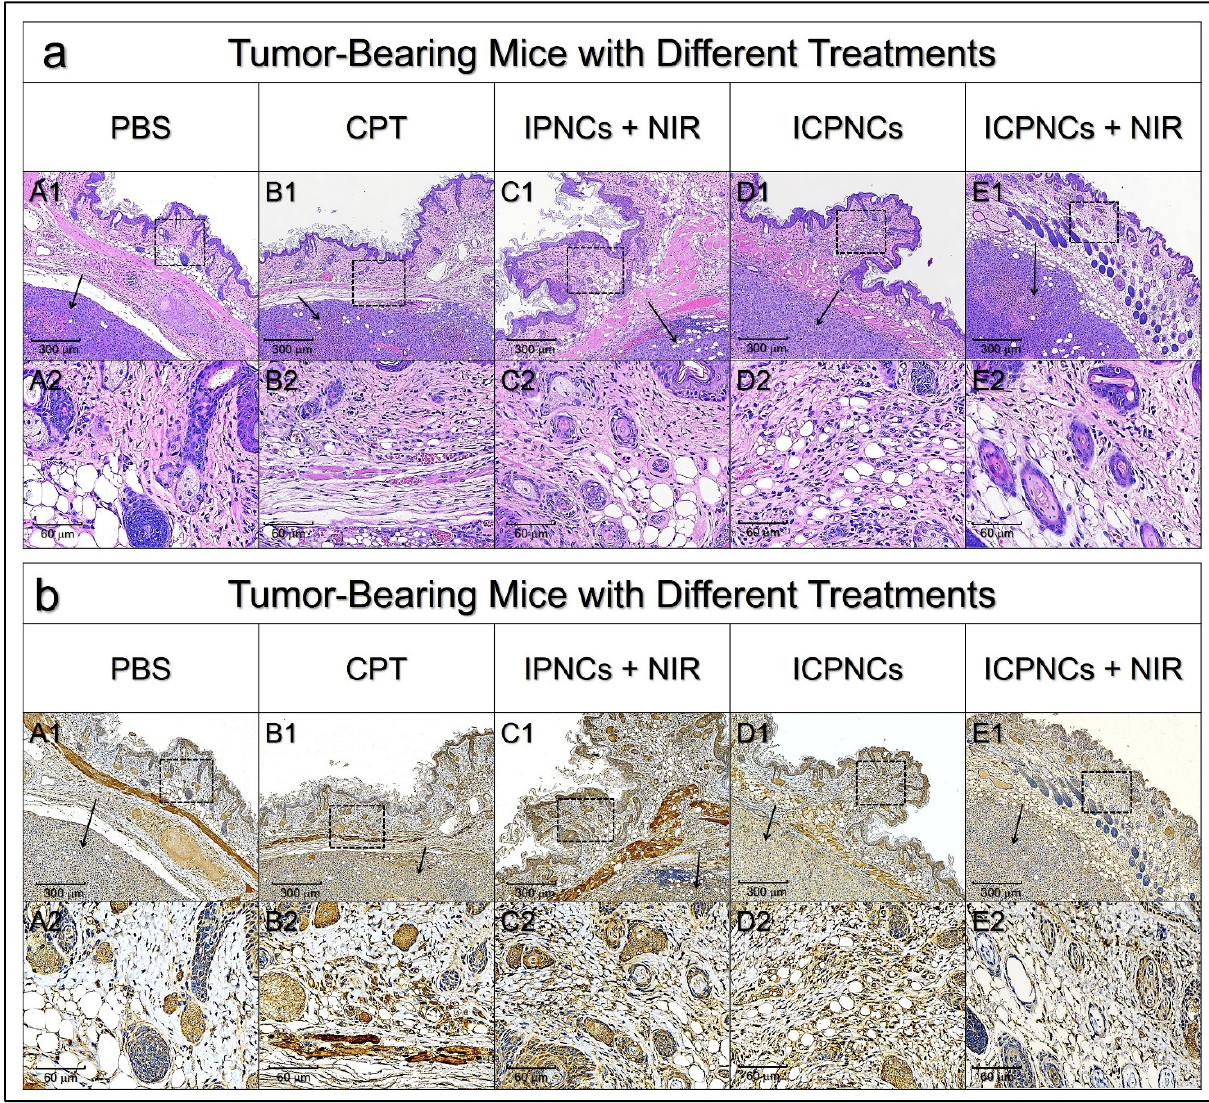
Figure 7. Histological analysis of skin tissue in the vicinity of the tumor. ( a , b ) Photomicrographic images of H&E-stained ( a ) or IL-1b IHC-stained ( b ) skin tissues at 4× (A1–E1) and 20× (A2–E2) magnifications. Columns A–E denote different treatments as indicated in the figure. Black arrows in A1–E1 indicate the tumor in the image. The photographs A2–E2 are the magnified images of the area marked by the dashed block in A1–E1.